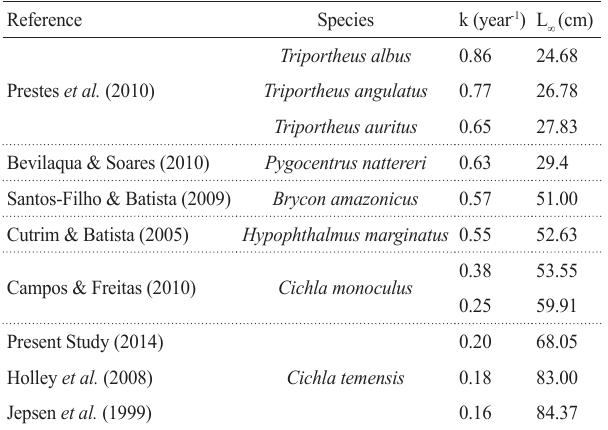
Table 3. Estimated growth coefficients and asymptotic lengths for Amazon fish species showing the inverse relationship between k and